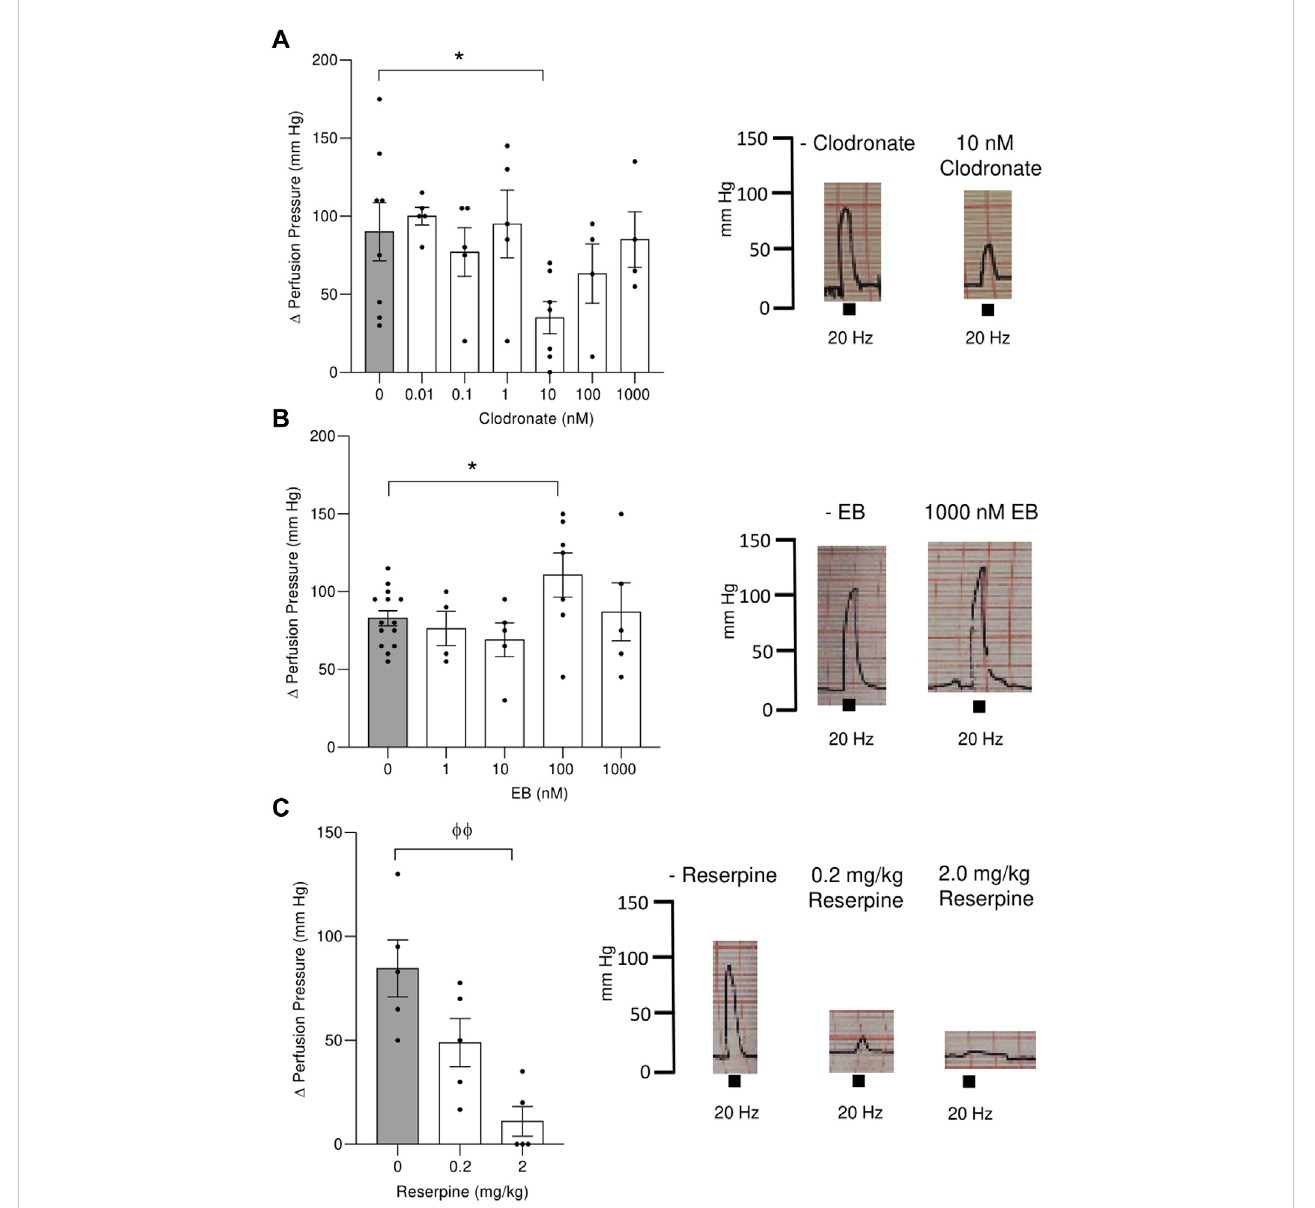
FIGURE 3 Electrical stimulation evoked an increase in the perfusion pressure of the mesenteric bed vascular territory and its modi fi cation following perfusion with either clodronate or Evans blue (EB) or mesenteries from rats pretreated with reserpine for 48 h. Left panel show columns depicting the increase in the mesentery perfusion pressure elicited by electrical nerve endings stimulation (20 Hz train of electrical pulses) expressed as the Δ increase in the mesentery perfusionpressureinpreparationsperfusedwithseveralclodronateconcentrations,upper (A) ;Evansbluemiddle (B) orratspretreatedwith.2or2 mg/kg reserpine for 48 h lower (C) . Right panel shows representative polygraphic traces of the changes in perfusion pressure recordings, with the respective calibrations (mm Hg). Columns represent mean values; bars the S.E.M. Gray columns represent matched tissues without drugs. Each closed circle in the columns represents experimental values obtained from separate rats. * p < .05, unpaired t-test; Φ Φ , p < .01, Mann – Whitney test, as compared to tissues without